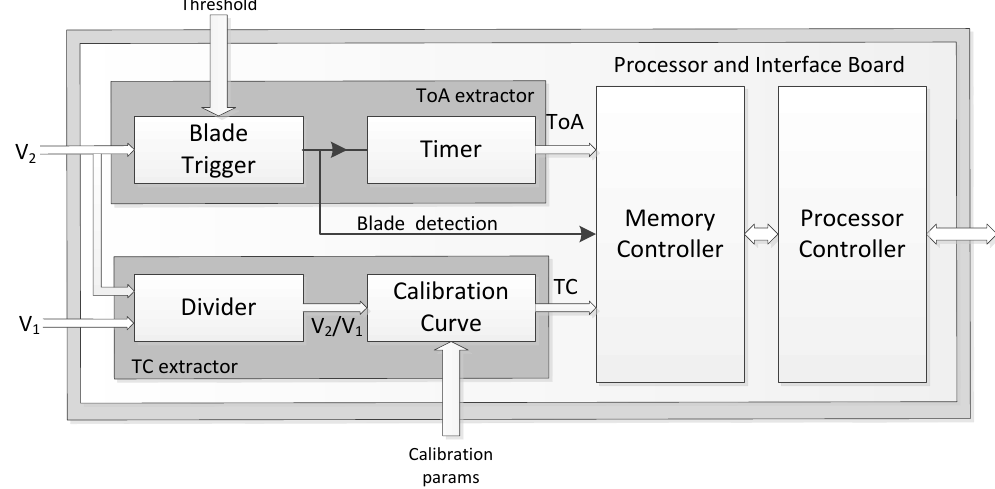
Figure 5. Architecture to measure TC and ToA with an optic sensor.